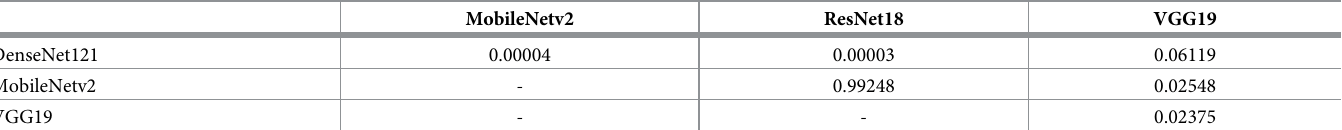
Table 7. p-values obtained after performing t-test using the baseline models for the 4-class classification